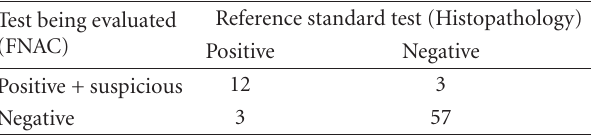
Table 6: Statistical analysis for carcinomatous